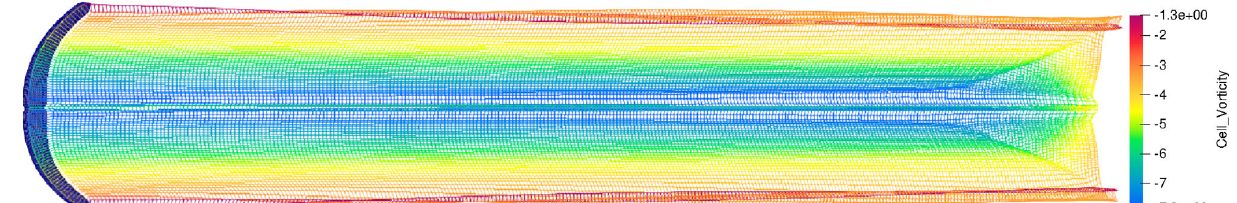
Figure 7. MIRAS simulation of the c-shape configuration with the free-wake filament-based